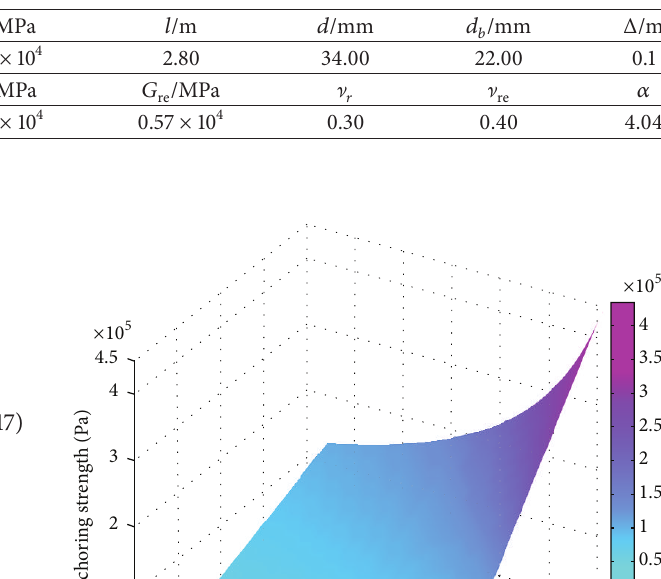
Table 1: Parameters of the anchoring system and surrounding rock mass ∗ .